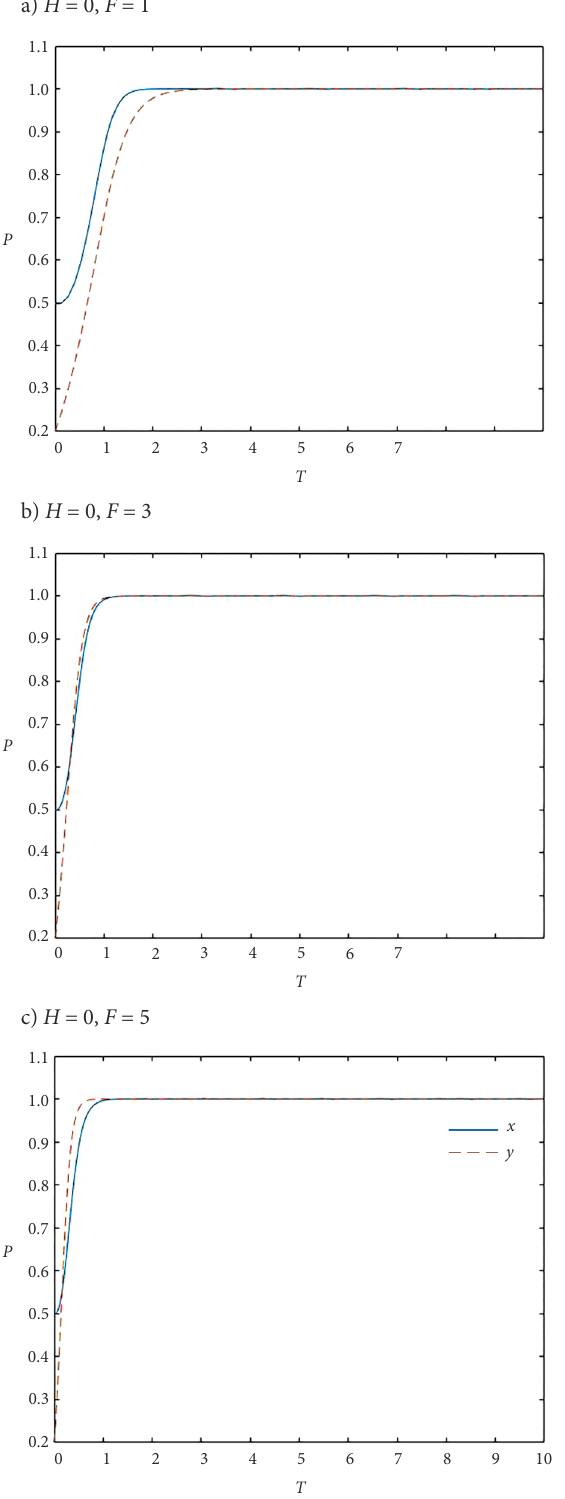
Figure 10. Probability trends for developers and customers with another data set ( F = 1, F = 3, F = 5)